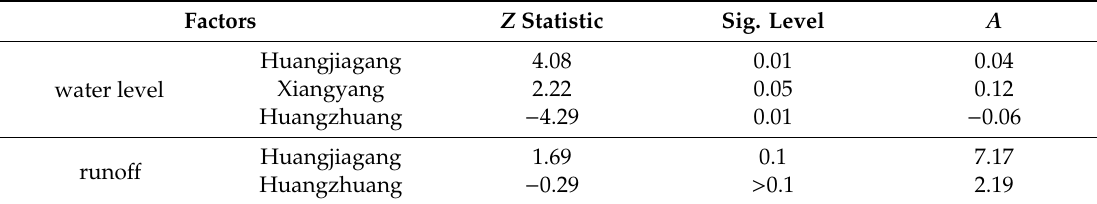
Table 5. Mann-Kendall analysis of changing trends in the hydrological